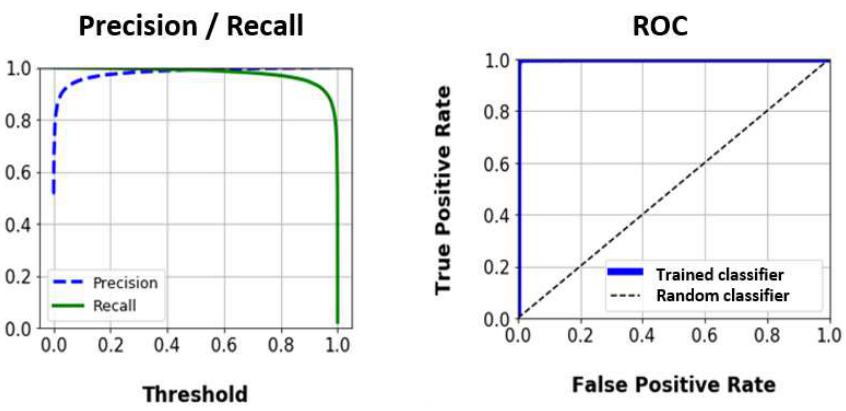
Figure 10. Precision-Recall curve and ROC curve of tennis strokes